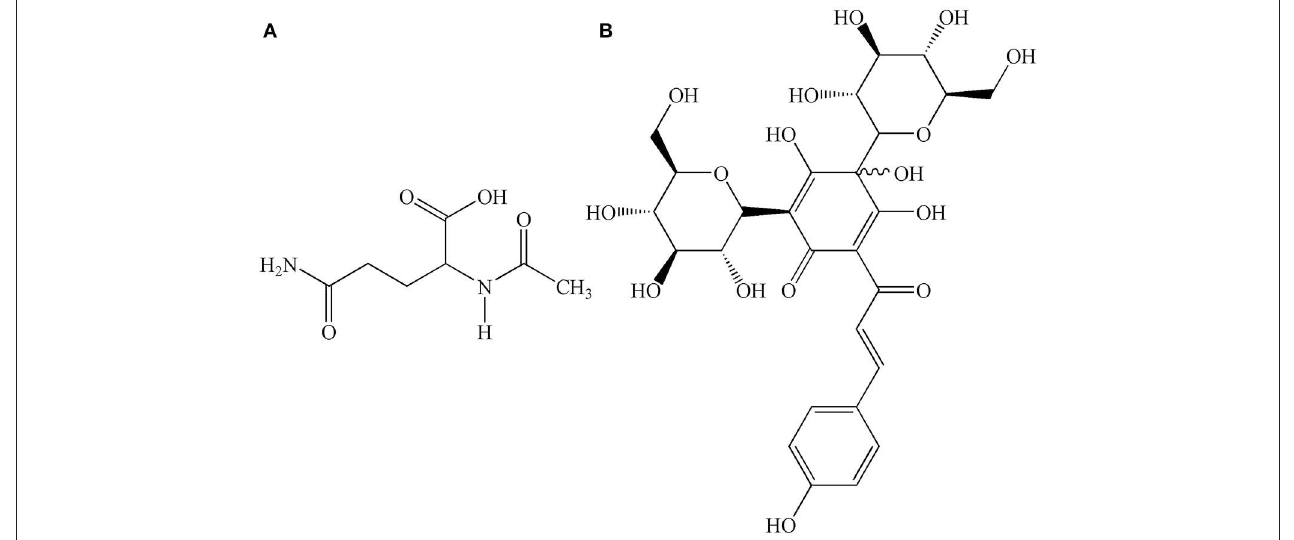
FIGURE 1 | Chemical structures of (A) aceglutamide, molecular formula: C 7 H 12 N 2 O 4 ; (B) HSYA, molecular formula: C 27 H 32 O 16 .